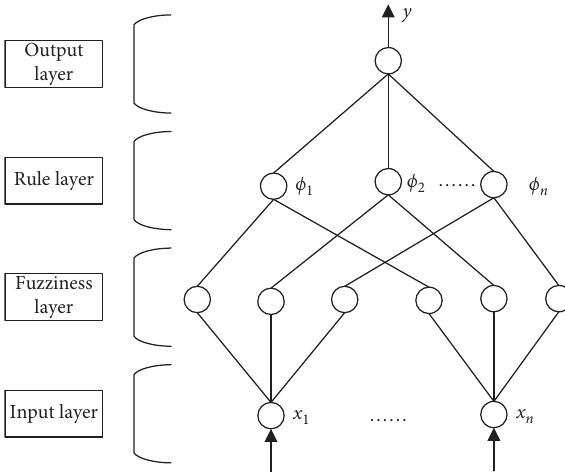
Figure 2: The structure of the fuzzy neural